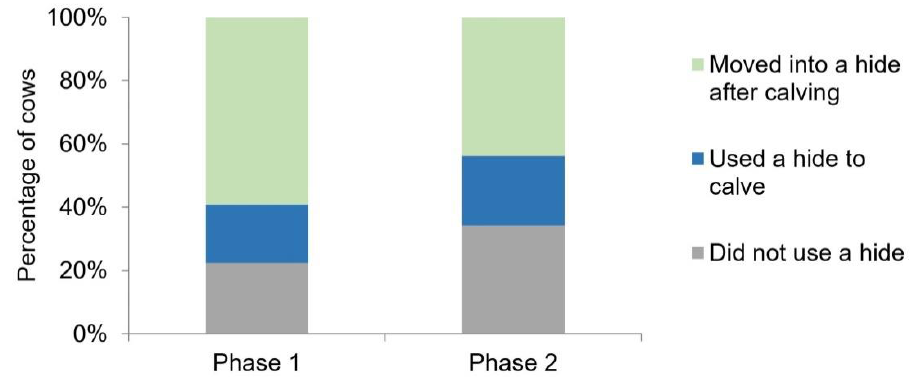
Figure 3. The percentage of cows and cow–calf pairs that did not use a hide, cows that calved in a hide, and cow–calf pairs that moved into a hide after calving during two phases of the study. Phase 1 ( n = 49) had consistently managed stocking density, daily bedding cleaning, and random allocation of cows to 1 of 2 calving pads each night. Phase 2 ( n = 41) followed the farm’s standard practice, with variable stocking density on both calving pads, and no bedding maintenance.